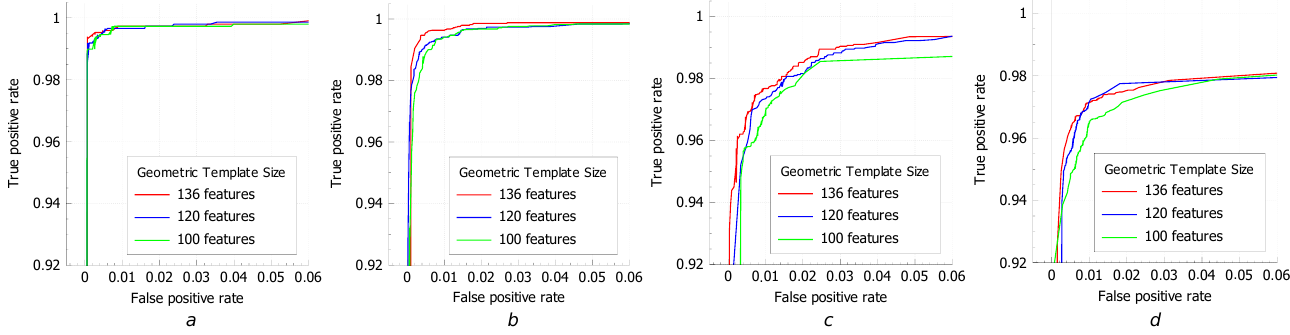
Figure 7. ROC curves of ANN classifier for various various compression of geometric features (PCA components): ( a ) Print/Capture Aberdeen; ( b ) Print/Capture Aberdeen v2; and ( c ) Print/Capture Utrecht; and ( d ) Print/Capture AR.